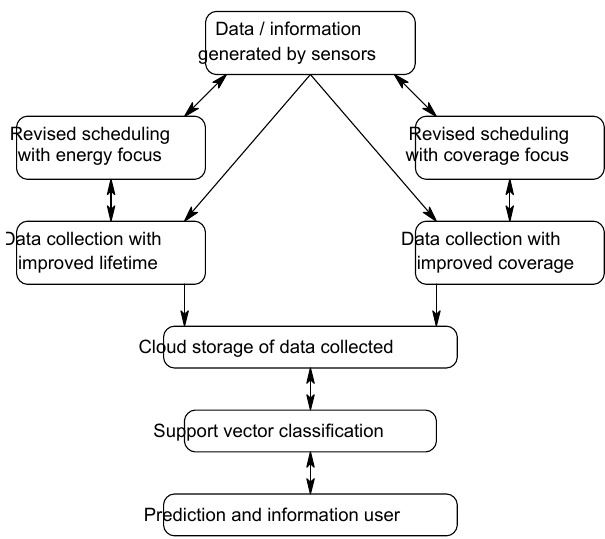
Figure 3. Energy and coverage improved data